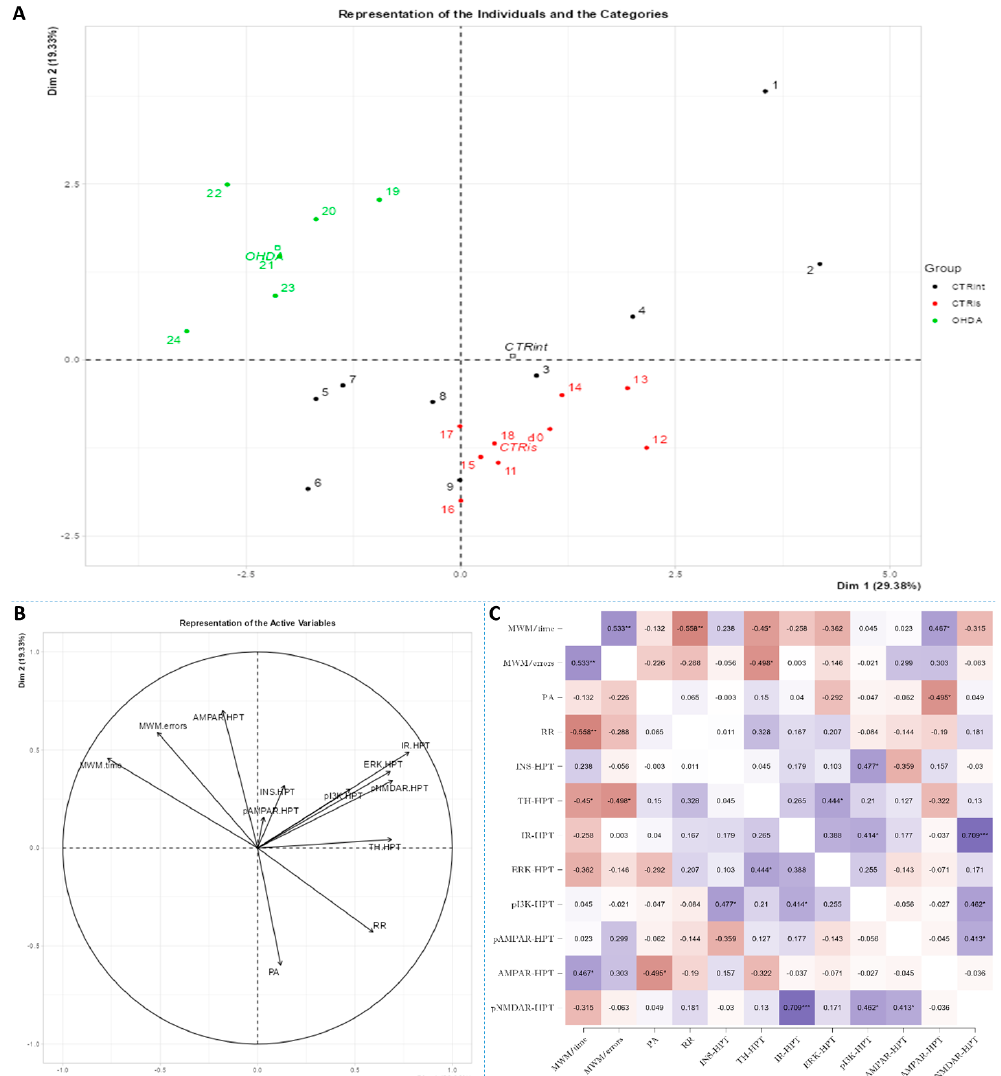
Figure 6. Principal component analysis and Spearman’s rank correlation of observed parameters in the hypothalamus 3 months after intrastriatal administration of 6 ‐ OHDA. Hypothalamic (HPT) principal component analysis is represented as a biplot ( A ) with coordinates of individual animals in respect to the 1st and 2nd dimensions (principal components) and a biplot graph of the variables’ contributions to the 1st and the 2nd principal component ( B ). Groups are represented in different colors: intact control (CTRint, black), sham-treated control (CTRis, red), animals treated intrastriatally with 6-hydroxydopamine (OHDA, green) ( A ). Spearman’s rank correlation of HPT parameters is represented as Spearman’s rho heatmap ( C ) with statistically significant correlations indicated with * p < 0.05, ** p < 0.001, *** p < 0.001. Dim 1-1st dimen- sion; Dim 2-2nd dimension; MWM-Morris Water Maze; PA-Passive Avoidance; RR-Rotarod; INS- insulin; TH-tyrosine hydroxylase; IR-insulin receptor; ERK-extracellular signal-regulated kinase; pI3K-phosphoinositide 3-kinases; AMPAR- α -amino-3-hydroxy-5-methyl-4-isoxazolepropionic acid receptor; NMDAR-N-methyl-D-aspartate